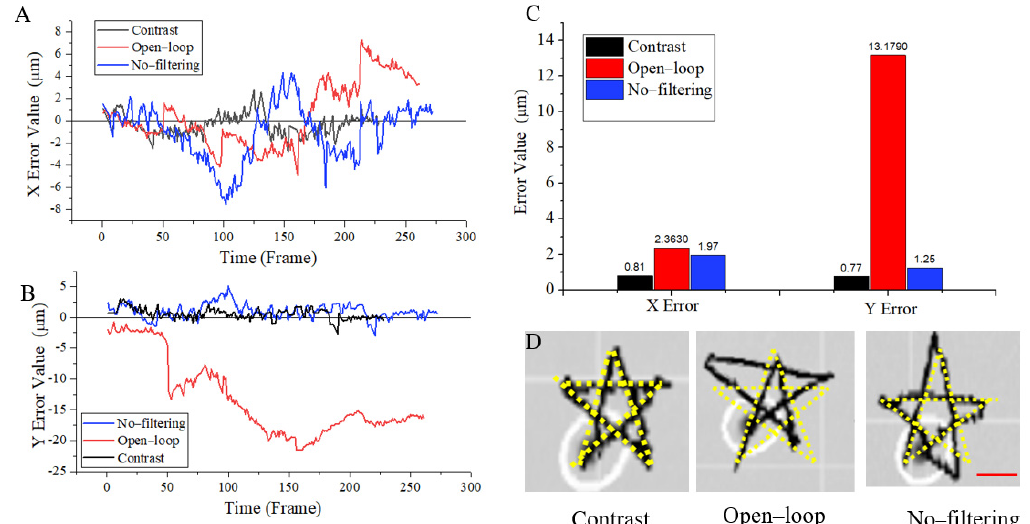
Figure 6. ( A – C ) The error in the X-axis and Y-axis directions for contrast, open–loop, and no–filtering systems. The contrast system is conducted with Kalman filtering and closed-loop control. ( A ) Error variation trend in the X direction. ( B ) Error variation trend in the Y direction. ( C ) The average value of the absolute error in X and Y direction. ( D ) Superposition diagram of the simulated path and actual moving path, in contrast, open–loop and no–filtering systems. Scale bars: 30 μ m.